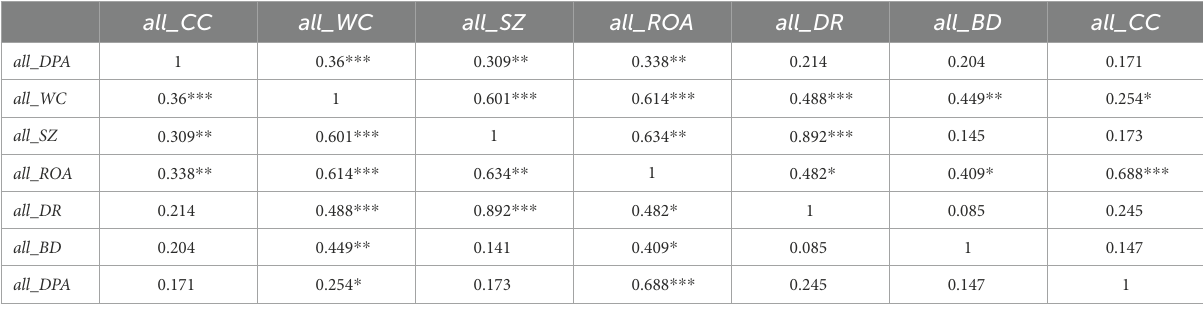
TABLE 2 Table of correlation test results.